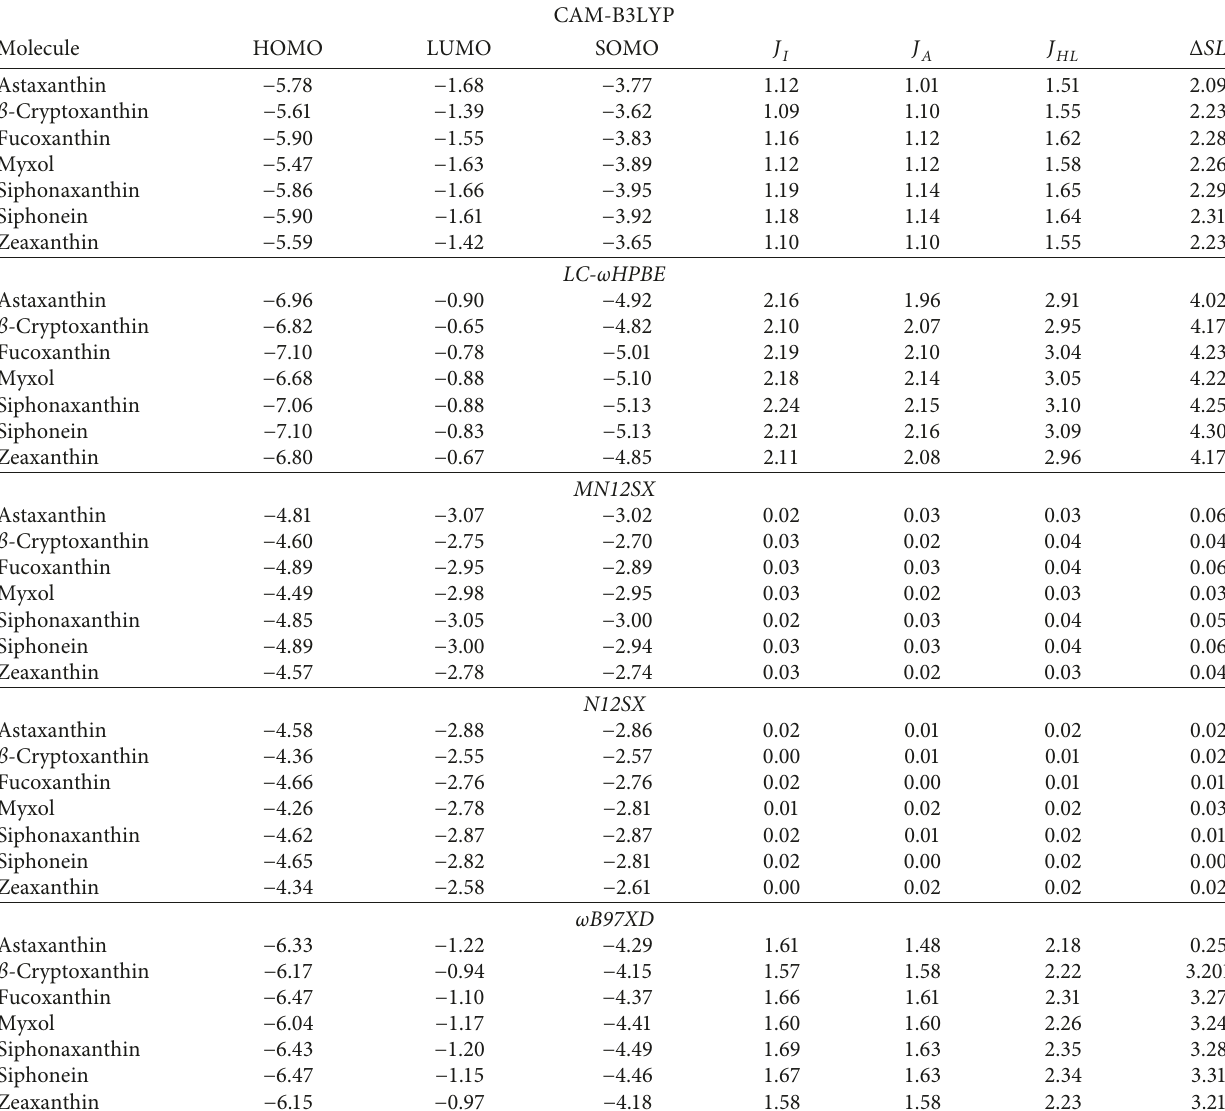
Table 3: HOMO, LUMO, and SOMO orbital energies (in eV) and the KID-related descriptors obtained with the five density functionals, the Def2TZVP basis set, and ethanol as the solvent.